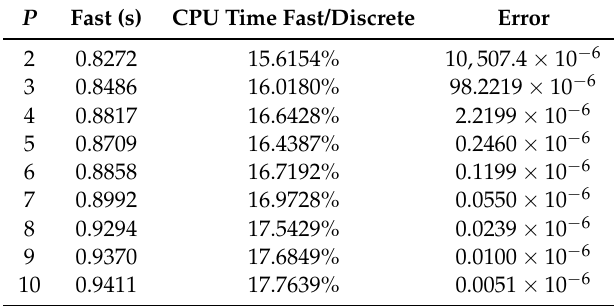
Table 2. Error and CPU time evolution for the all-metallic filter ( R = 9 cavities) as the number of frequency points for the fast sweep ( P ) increases. Discrete sweep used 500 points and took 5.298 s.